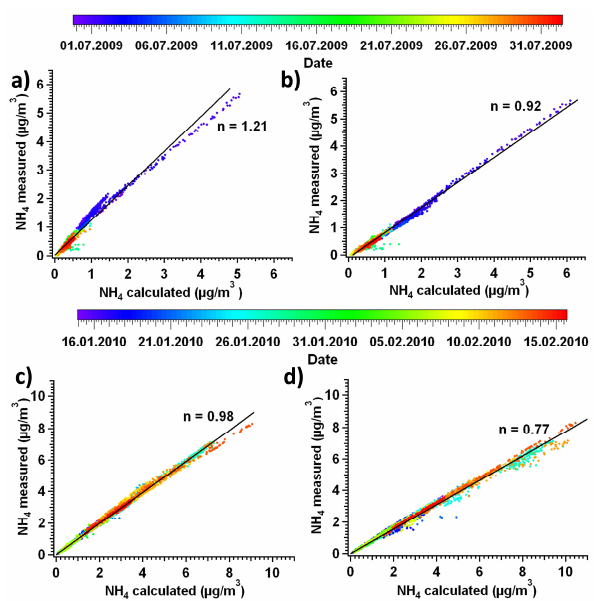
Fig. 5. Comparison of NH 4 measured and predicted for ammonium bisulfate (a, c) and ammonium sulfate (b, d) in summer (top) and Figure 5. Comparison for NH 4 measured and predicted for ammonium bisulfate (a,c) and 3 winter (bottom), where n denotes the slope of the regression line. ammonium sulfate (b,d) in summer (top) and winter (bottom), where n denotes the slope of 4 the regression line. 5